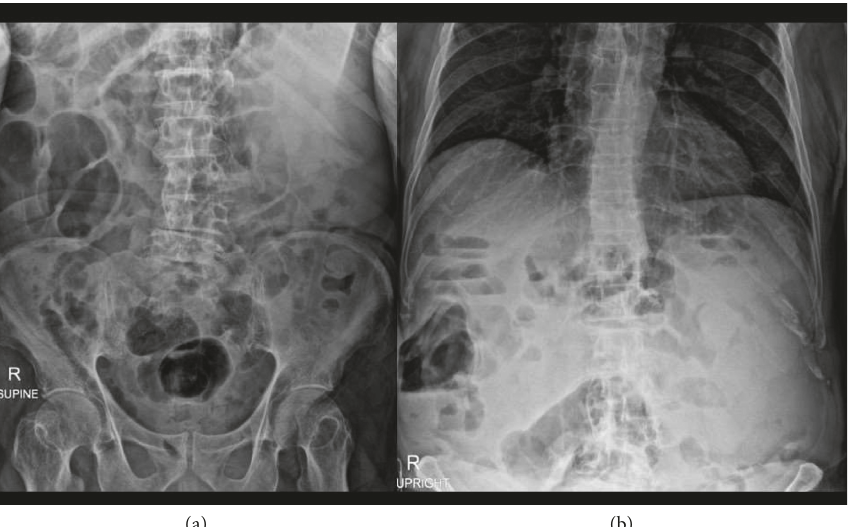
Figure 1: Supine (a) and upright (b) abdominal radiographs revealed a large well-defined soft tissue opacity at the left upper quadrant of abdomen, deviating left-sided colon medially. No signs of bowel obstruction were noted.